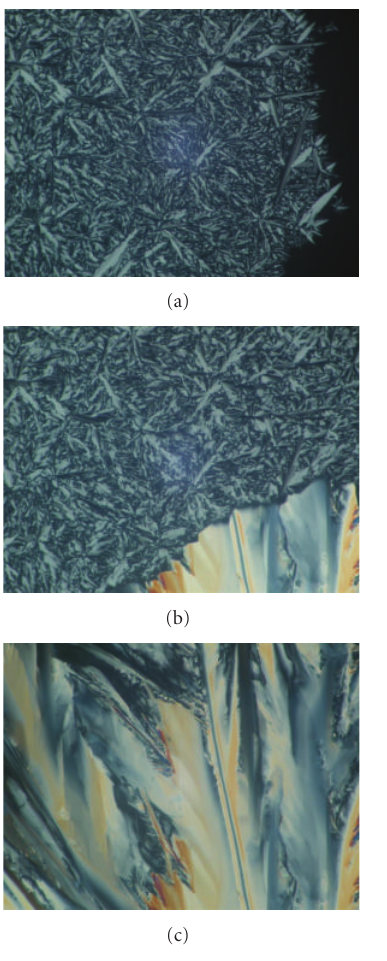
Figure 2: Polarized optical micrographs of cholesteryl acetate taken during cooling from the isotropic phase at (a) 93.9 ◦ C, (b) 93.7 ◦ C, and (c) 25 ◦ C.